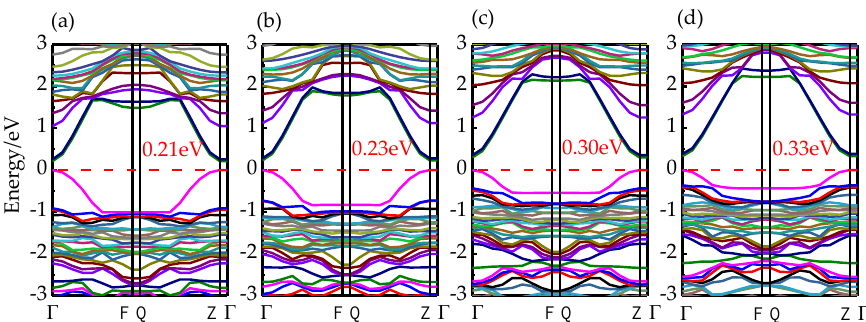
Figure 3. The band structures of 1I-BiOI/TiO 2 heterojunction under ( a ) −2%, ( b ) −1%, ( c ) 1% and ( d ) 2% {001} IPBTSs. Red dashed line represents the Fermi level.